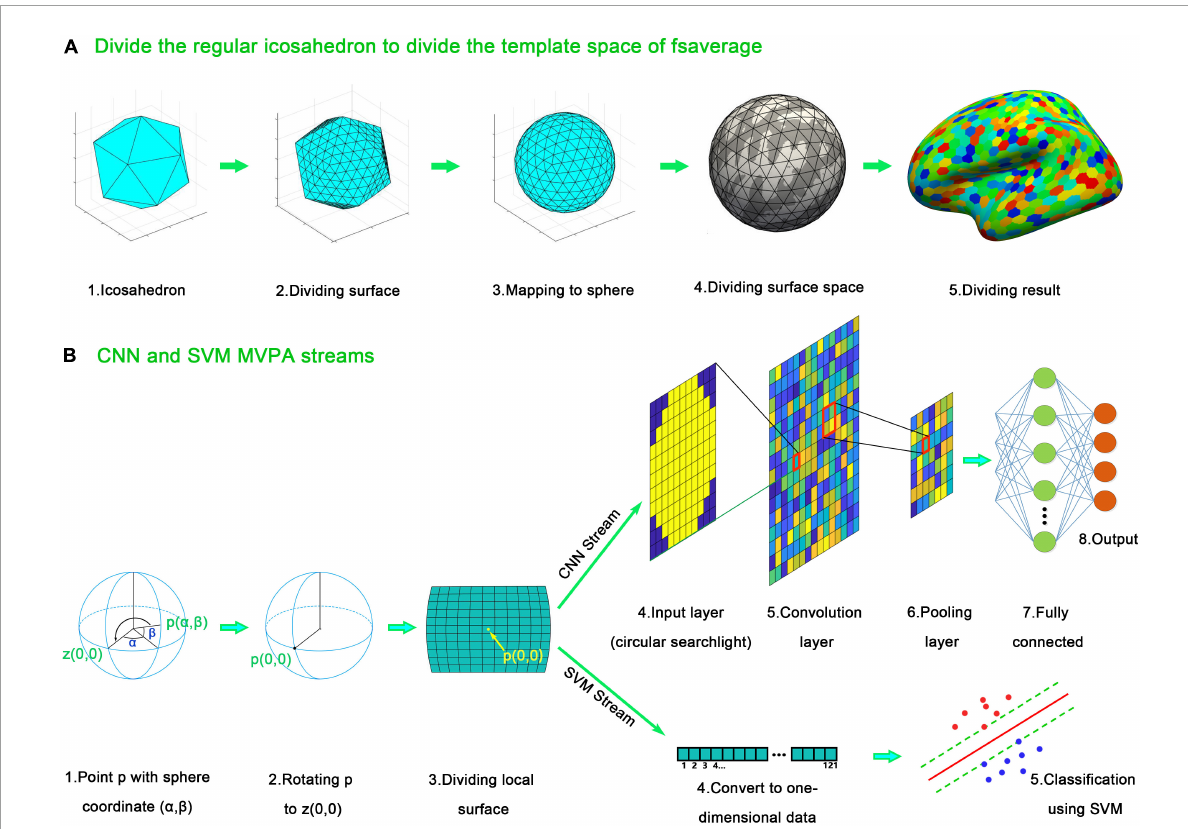
FIGURE3 Surface space-based multivariate pattern analysis (MVPA) stream of SF-MVPA, which is adopted from Li et al. (2022b). (A) Surface dividing method. The spherical space of fsaverage is divided to avoid repeated calculation. The edges of the icosahedron are divided into 40 parts. The corresponding points are connected, forming new vertices. The vertices on the divided icosahedron are projected to a sphere and mapped to the spherical space of fsaverage. The vertices on the spherical space of fsaverage are grouped into the nearest vertices projected from the divided icosahedron, forming the downsampled spherical space of fsaverage. (B) Surface space-based MVPA streams. For each vertex p ( α , β ) on the downsampled spherical space of fsaverage, a rotation operation is performed. Vertex p is rotated to vertex z (0, 0). After that, a grid-like searchlight is acquired. The BOLD signals of the vertices (from the non-down-sampled fsaverage space) in the cells are averaged, forming an n1 × n1 image (n1 represents the number of cells of each side of the grid). A circle with a radius of n1/2 is applied to the image, forming a circular searchlight. The circular searchlight serves as the input data in the following analysis of the CNN stream. In the support vector machine (SVM) stream, the circular searchlight is converted into a one-dimensional vector and serves as the input